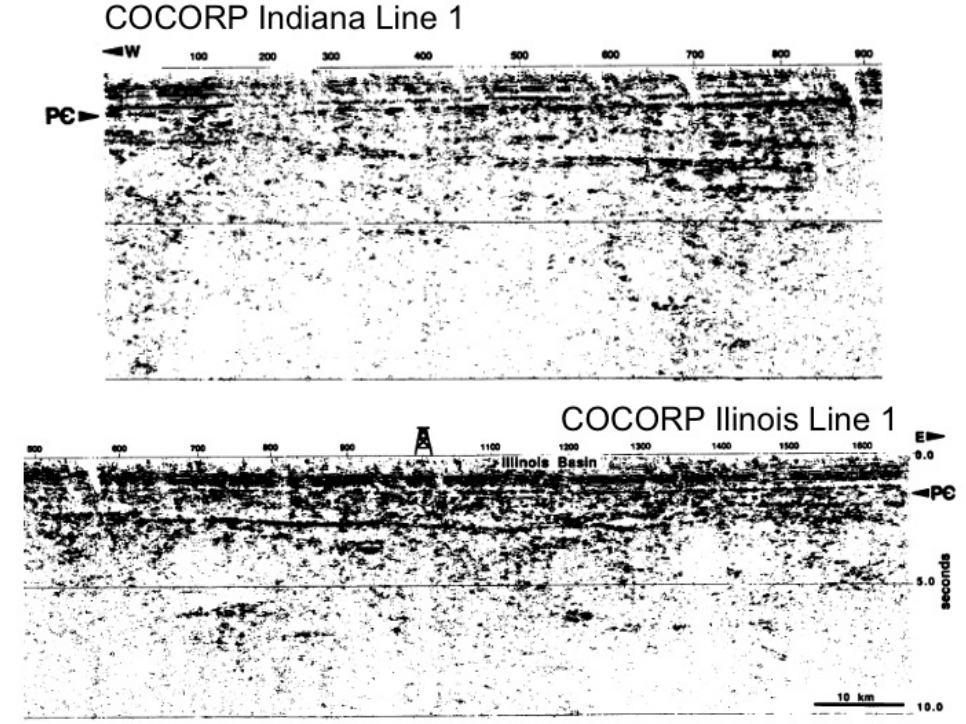
Figure 9. Layered basement reflections from the COCORP reflection profiles in western Ohio [67].